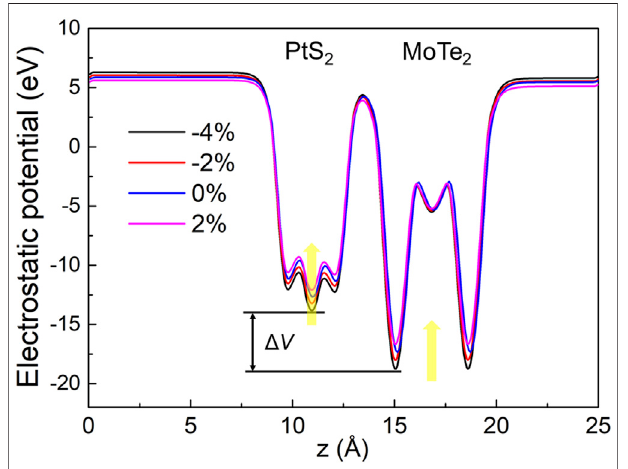
FIGURE 6 | Calculated optical absorption of the MP vdW heterostructure under the external